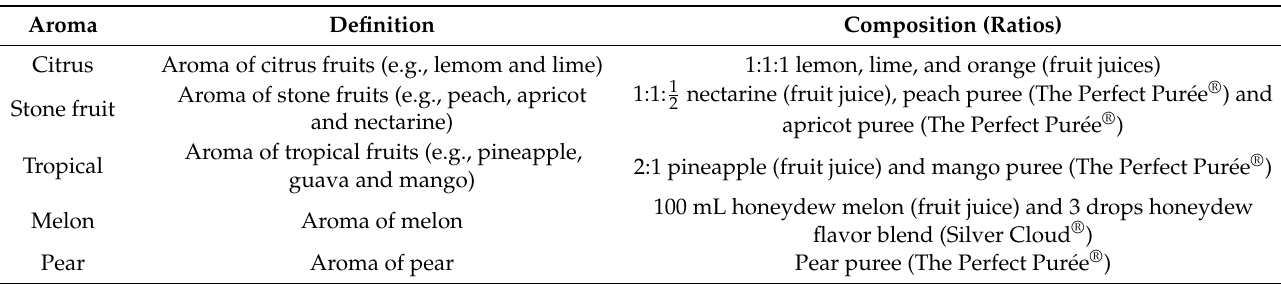
Table 3. Composition of the poles used in PPM.